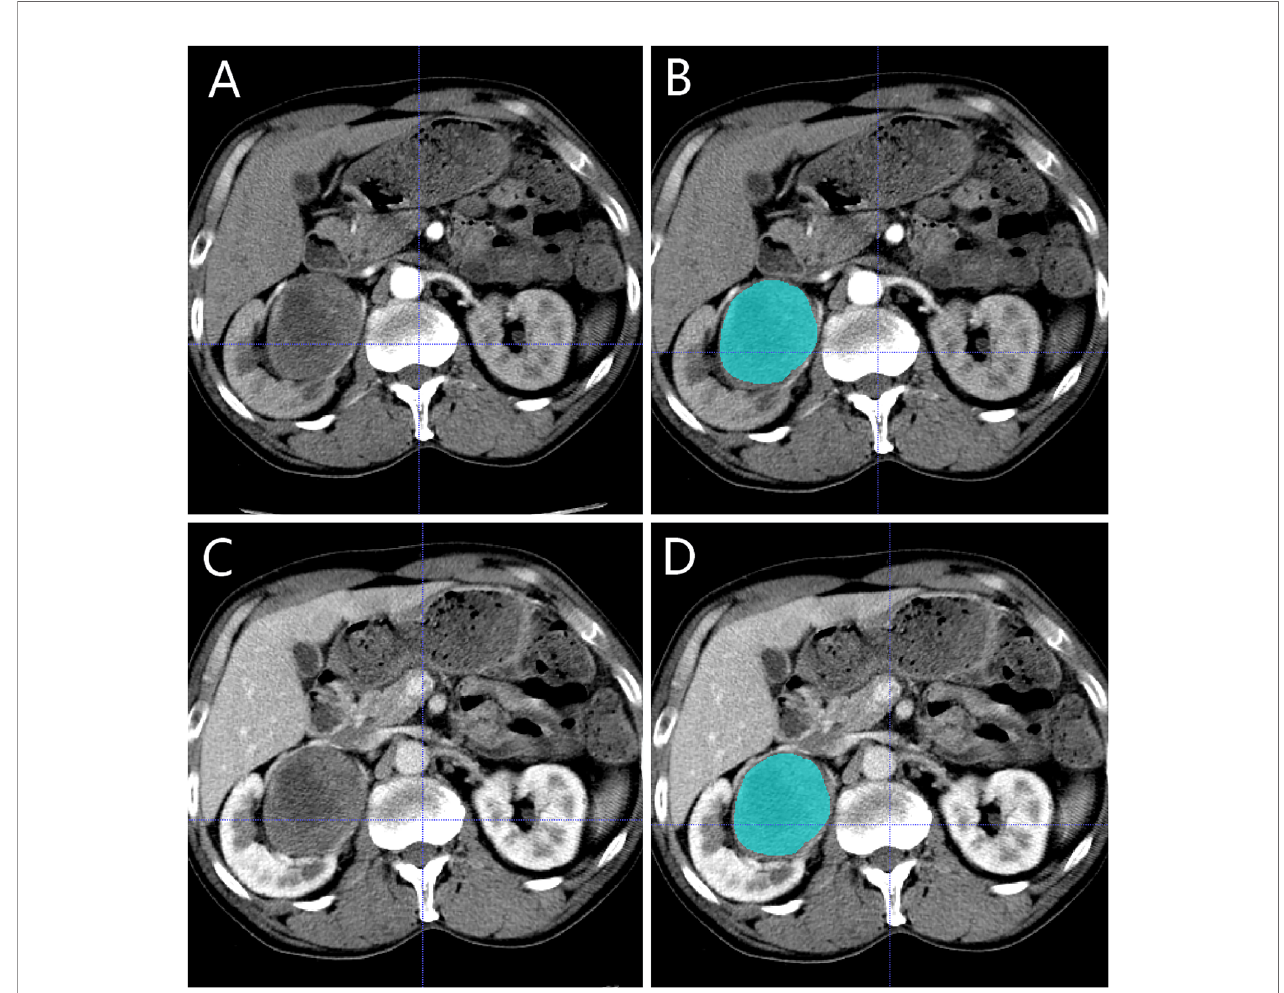
FIGURE 3 | Manual segmentation of the tumour on the center axial slice of the pRCC type 2. (A, B) is the corticomedullary phase (CMP); (C, D) is the nephrographic phase